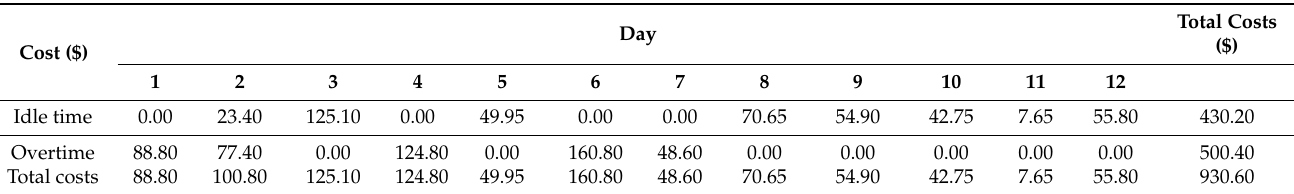
Table 15. Idle time and overtime incurred costs over 12 days ($).